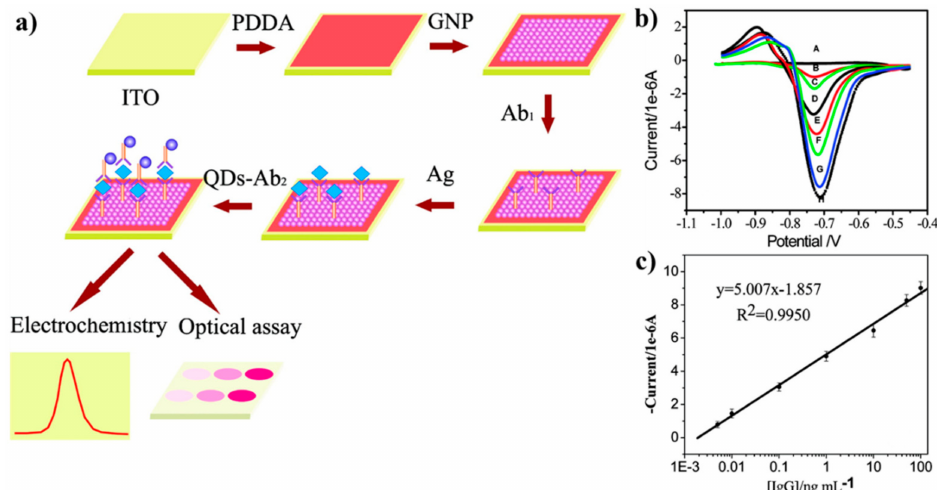
Figure 6. ( a ) Schematics of the CdTe QDs label-based immunoassay for the detection of protein. ( b ) Square wave voltammograms for the determination of HIgG (0–100 ng/mL). ( c ) The correspond- ing calibration curve on a semilog scale. Reproduced with permission from [46]. Copyright © 2020, American Chemical Society.